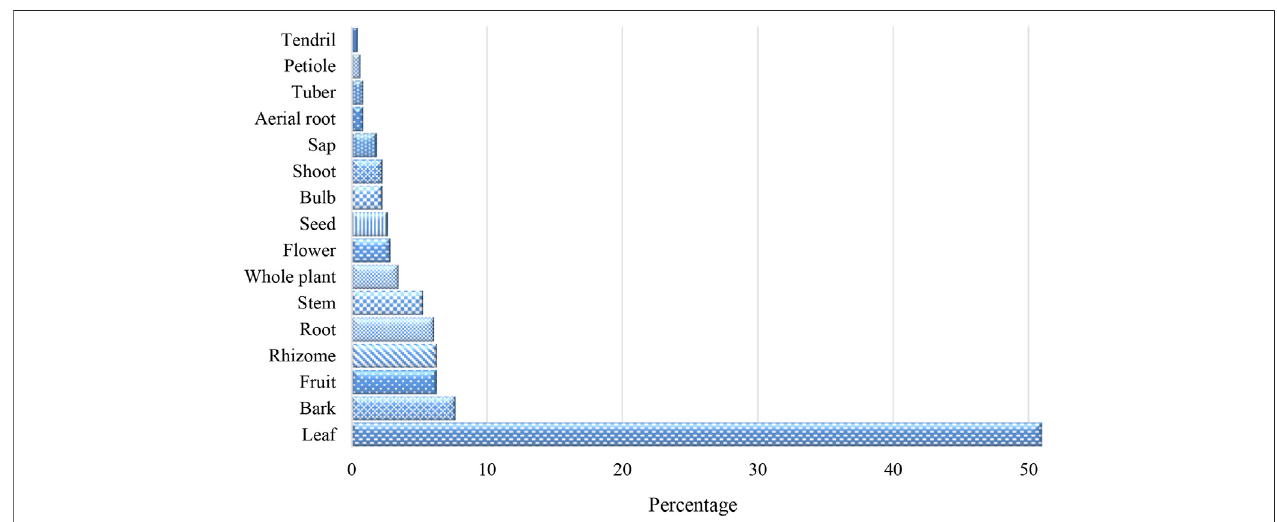
FIGURE 4 | Medicinal plant parts used.